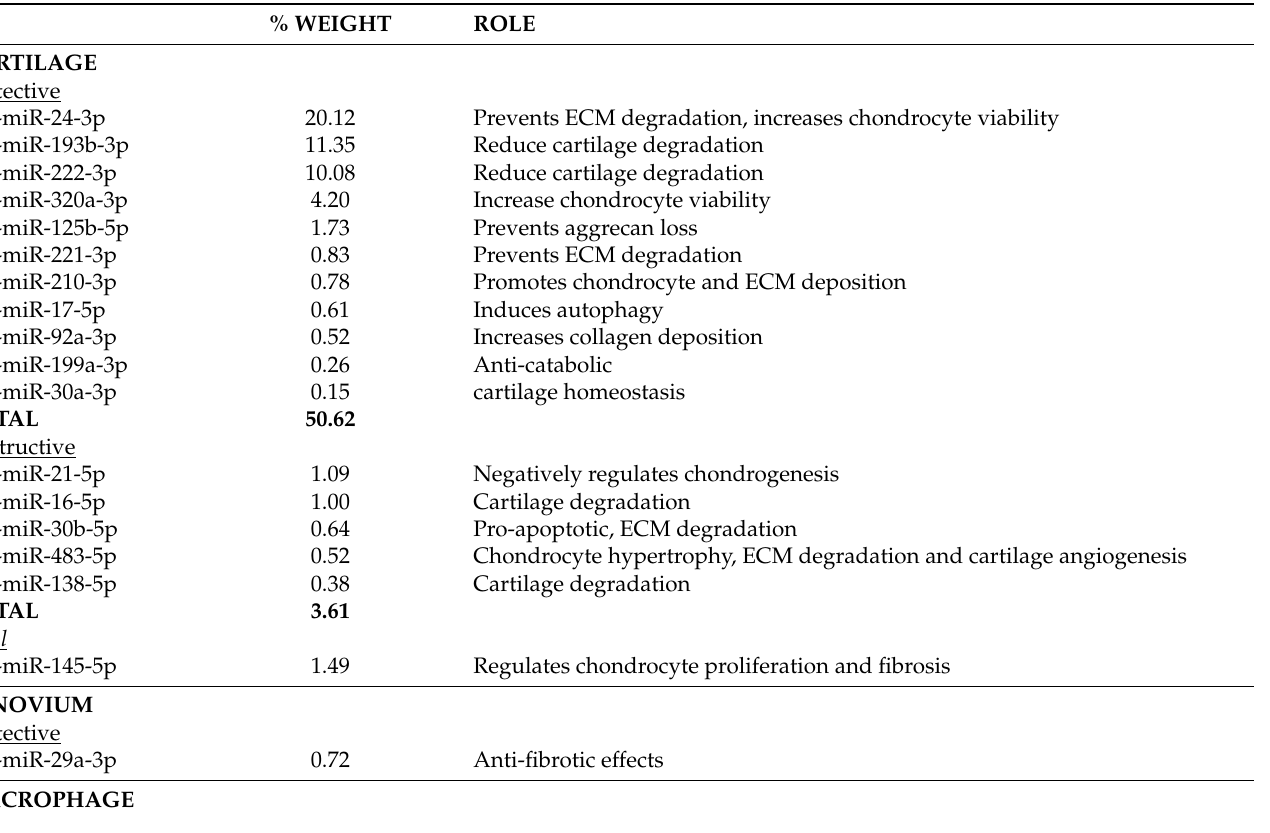
Table 5. First quartile EV-miRNAs’ role in OA-related tissues and cells. %